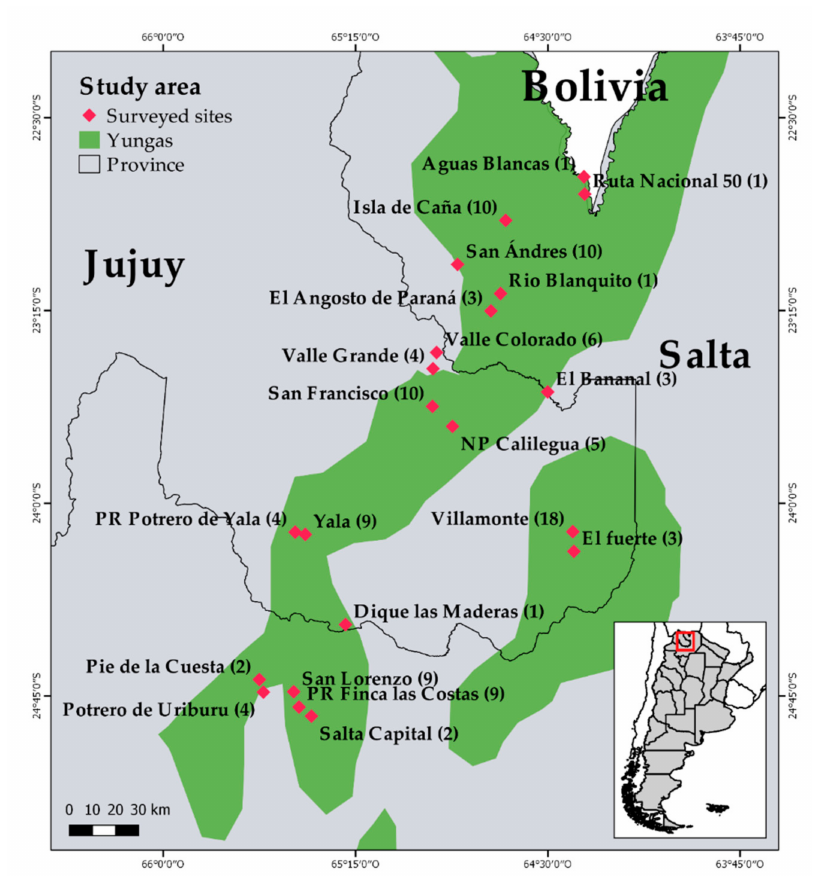
Figure 1. Distribution of the Yungas ecoregion in the study area and sites where interviews were performed. The number of interviews carried out at each settlement is indicated in parenthesis. NP = National Park, PR = Provincial